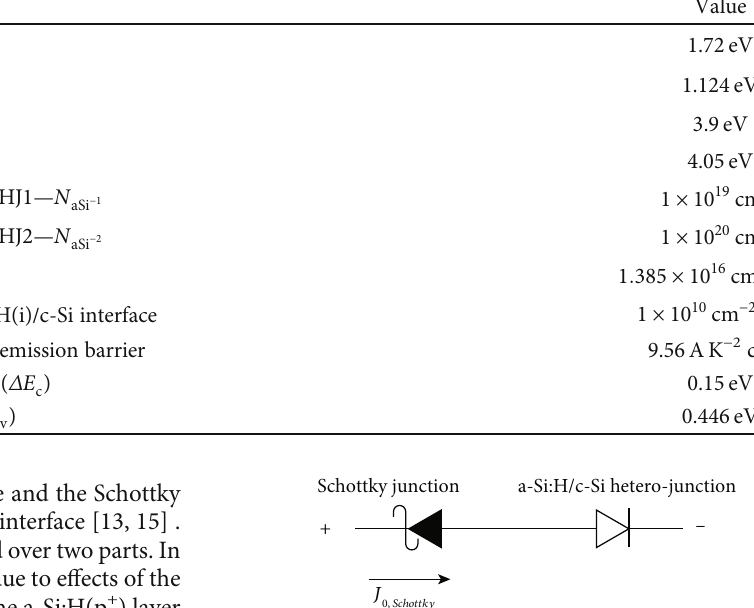
Figure 2: Simple diode model for the forward biased SHJ under dark (with j = 0 ) or under low-level injection conditions (with a ph positive j ph